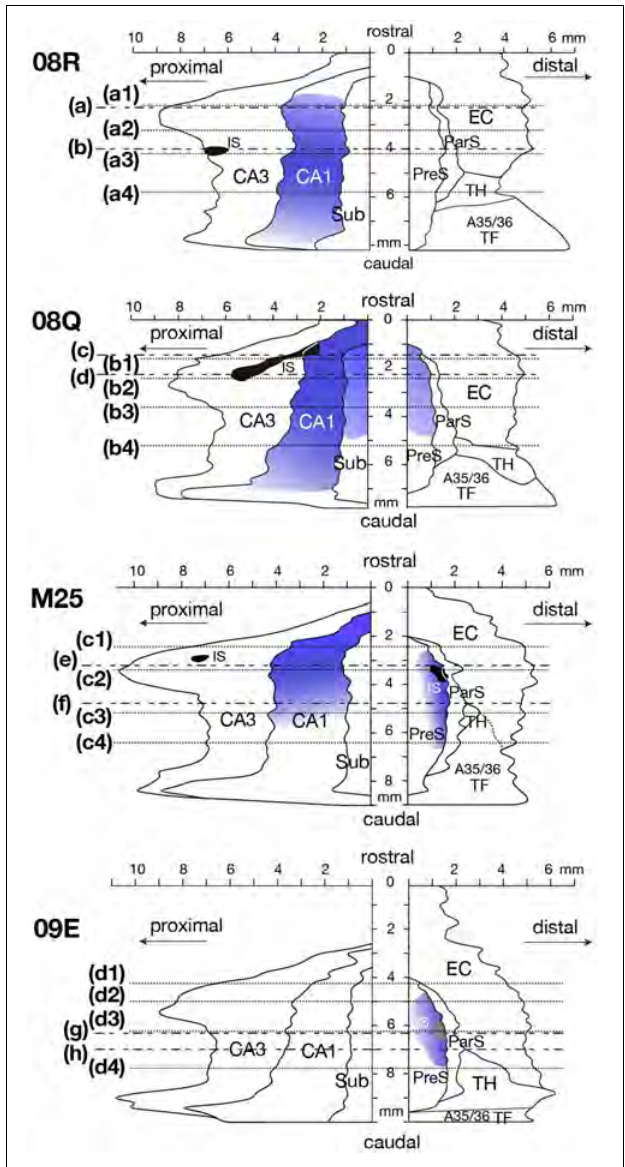
FIGURE 6 | Distribution of BDA injection sites and anterogradely labeled terminals of four cases are represented on a two-dimensional unfolded map. Black regions indicate BDA injection sites that extended to all layers. The gray region in case 09E indicates the injection site that was restricted to the superficial layers of PreS. Each blue colored region indicates the distribution and intensity of labeled terminals. Dotted lines of each unfolded map indicate the rostrocaudal level of each section in Figure 8 . Alternate long-and-short dash lines in the unfolded map of cases 08R, 08Q, M25 and 09E indicate the rostrocaudal level of each panel in Figure 7 . A35/36, areas 35 and 36 (the perirhinal cortex); CA, cornu ammonis; DG, dentate gyrus; EC, entorhinal cortex; IS, injection site; ParS, parasubiculum; PreS, presubiculum; Sub, subiculum; TF, area TF; TH, area TH. Note that anterograde labels were densely distributed in PreS along the rostrocaudal axis in the experimental cases where BDA injection included CA1 (case 08Q) or the superficial layers of PreS (case 09E) or all layers of PreS (case M25). Note also that many labeled terminals were observed in CA1 in the cases where BDA injection site included CA3 (cases 08R, and M25). In case 08Q, where BDA injection included CA1, labeled terminals were densely distributed also in